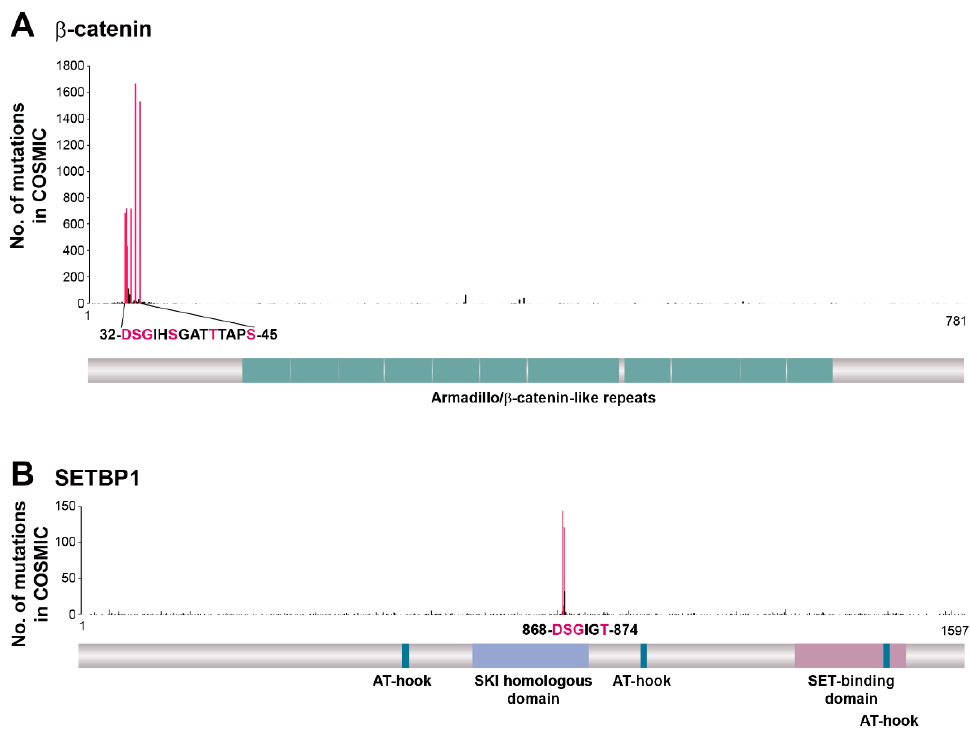
Figure 2. Distribution along the encoded protein sequences of CTNNB1 ( β -catenin gene) and SETBP1 mutations identified in the genomes of cancer patients. The numbers of CTNNB1 ( A ) and SETBP1 ( B ) genetic alterations were obtained from the COSMIC database (version 90). Mutations corresponding to the consensus sequence of the phosphodegron for β -TrCP are shown in pink.